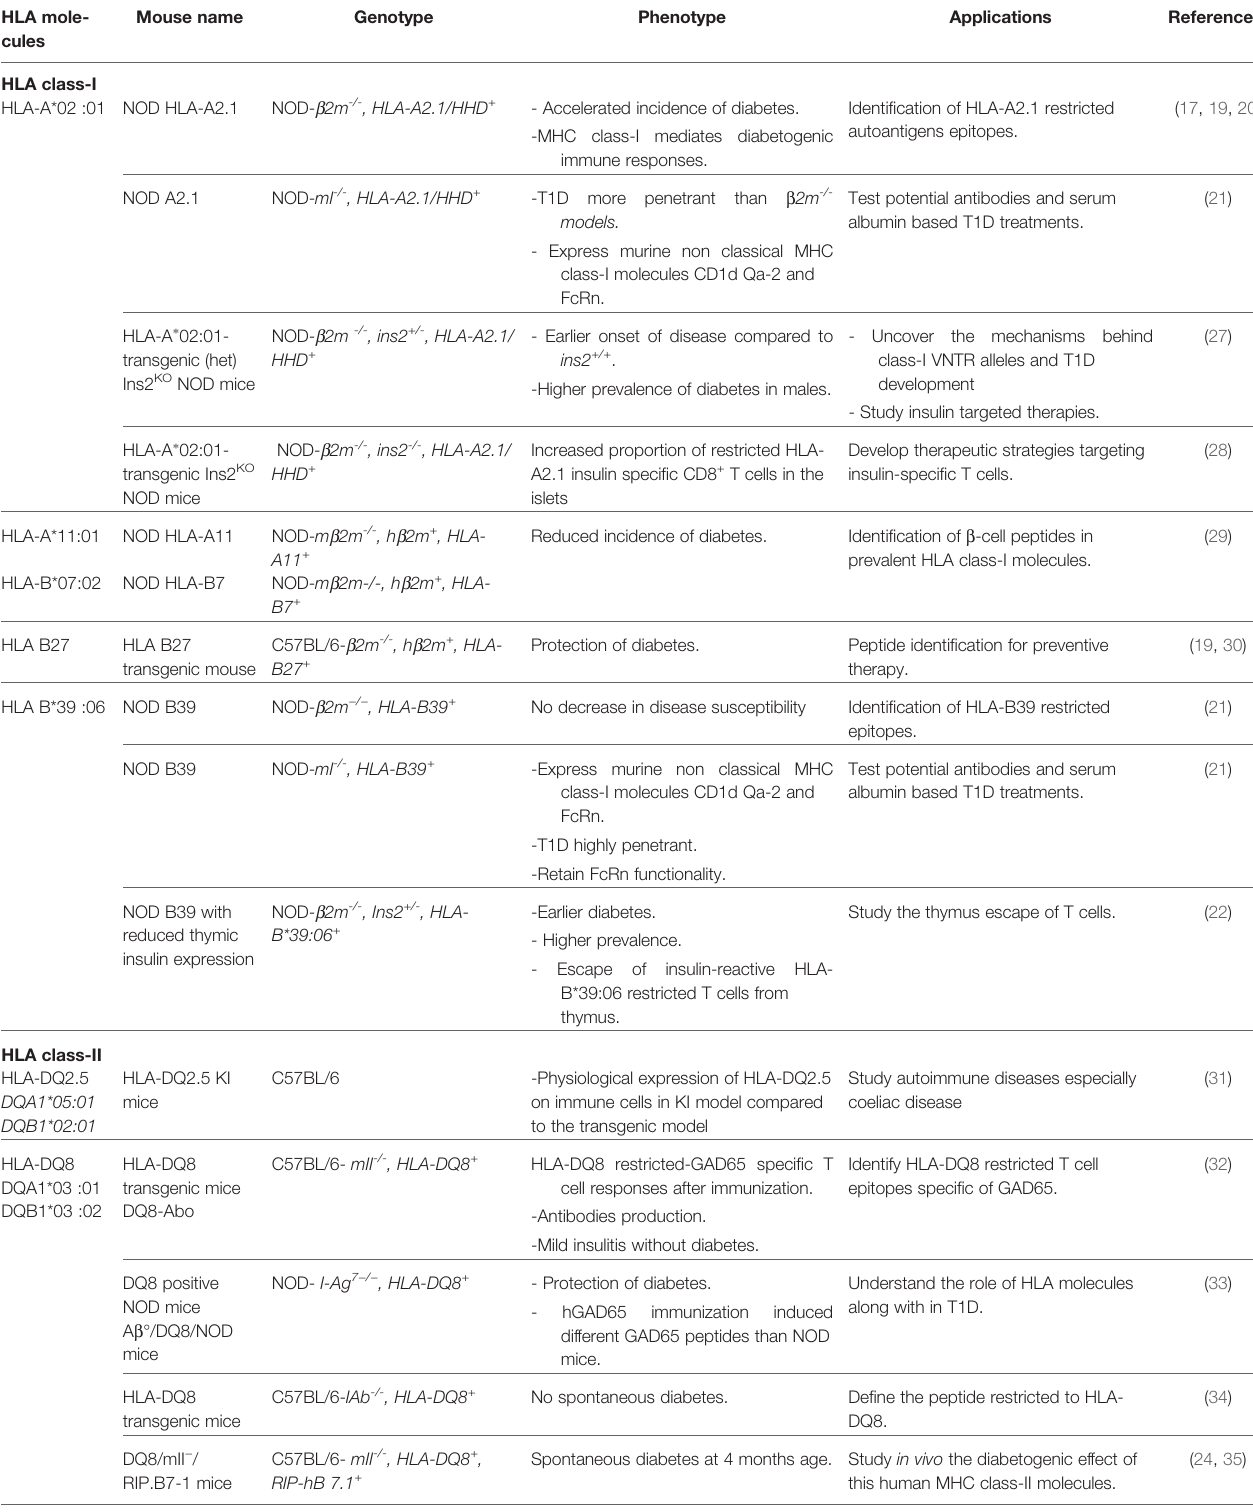
TABLE 1 | HLA transgenic mouse models. HLA mole-